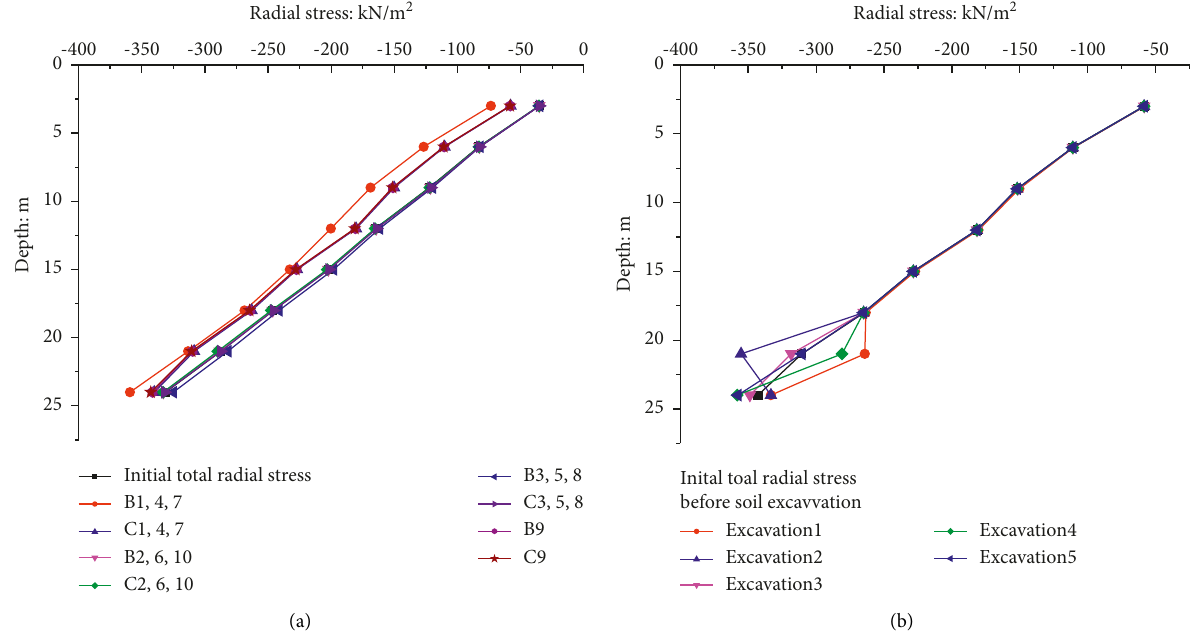
Figure 27: Earth pressure varies with depth. (a) Stage of forming gutters and wall. (b) Stage of shaft excavation.